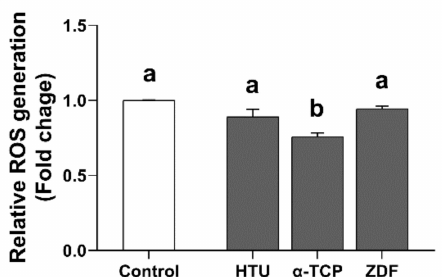
Figure 2. ROS generation in frozen germ cells after post-thaw recovery with antioxidant or apoptosis inhibitor supplementation. The ROS level was evaluated 12 h after post-thaw recovery in cryo-thawed germ cells. The values are expressed as the mean ± SEM ( n = 3). Statistical analysis was performed using one-way ANOVA coupled with Tukey’s post-hoc test. Different letters above each column indicate statistically significant differences ( p < 0.05). HTU, Hypotaurine; α -TCP, α -tocopherol; ZDF, Z-DEVD-FMK.